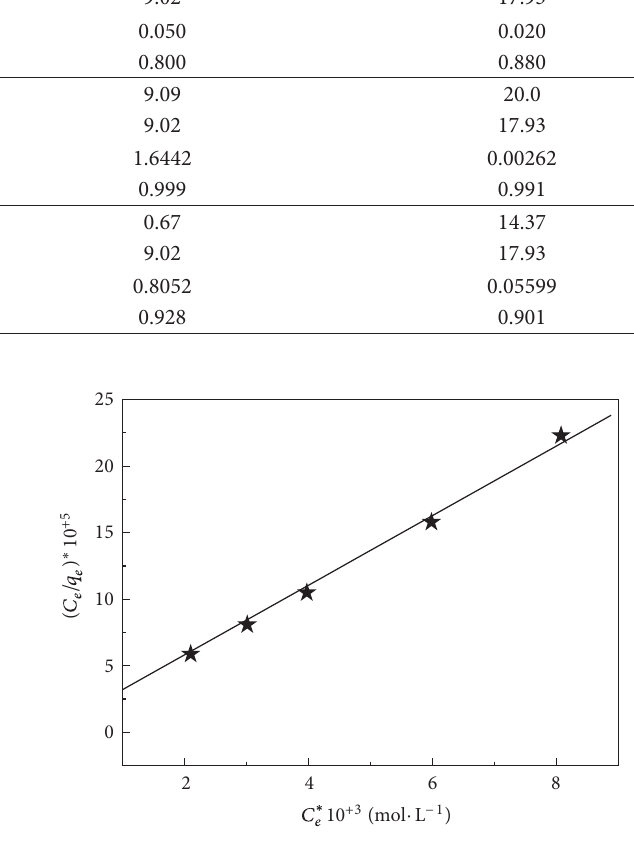
F 6: Langmuir plot for the adsorption of Cd(II), m = 0.030g, V = 5mL, initial pH = 5.0, and equilibrium time =